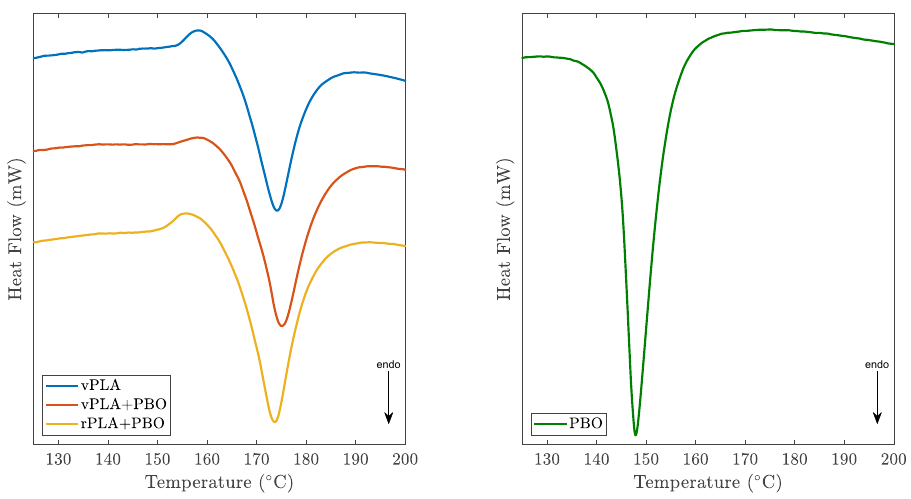
Figure 7. DSC thermograms recorded during the second heating of samples: PLA formulations ( left ); neat chain extender ( right